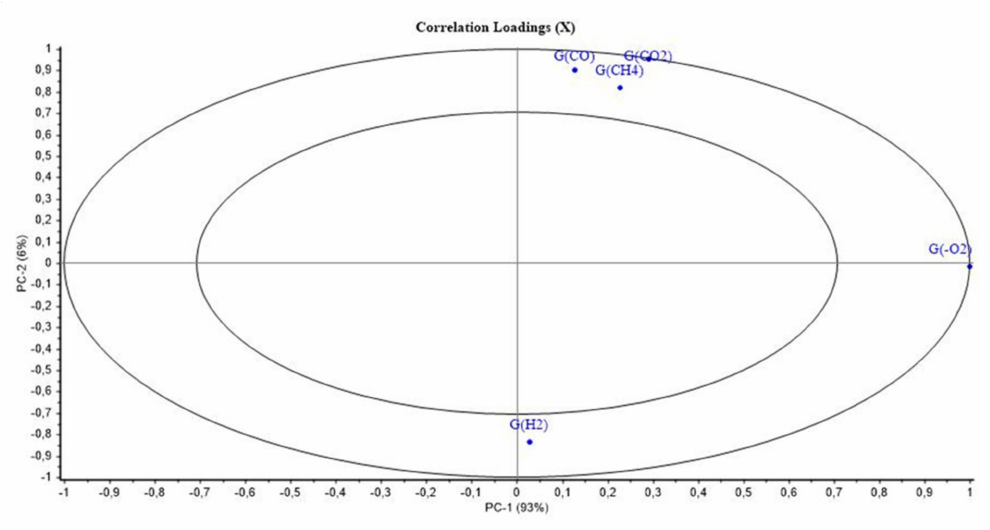
Figure 10. PCA loading for PC1 and PC2 (Mod